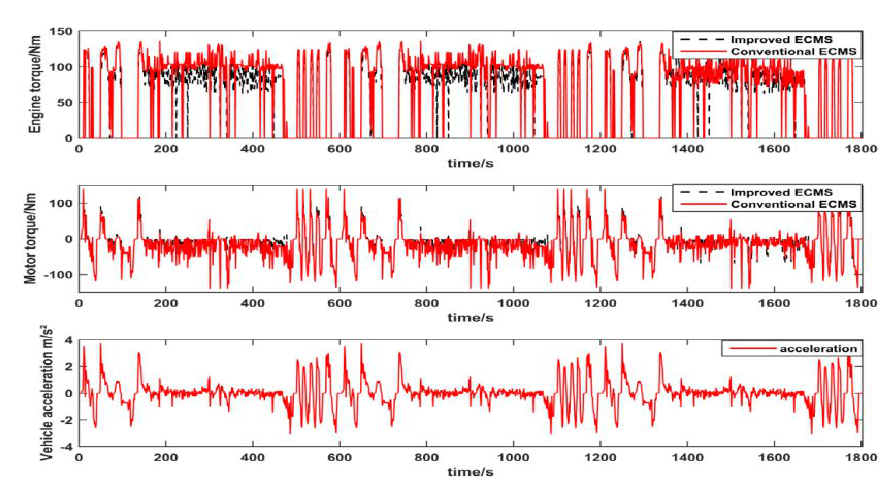
Figure 11. Battery SOC.